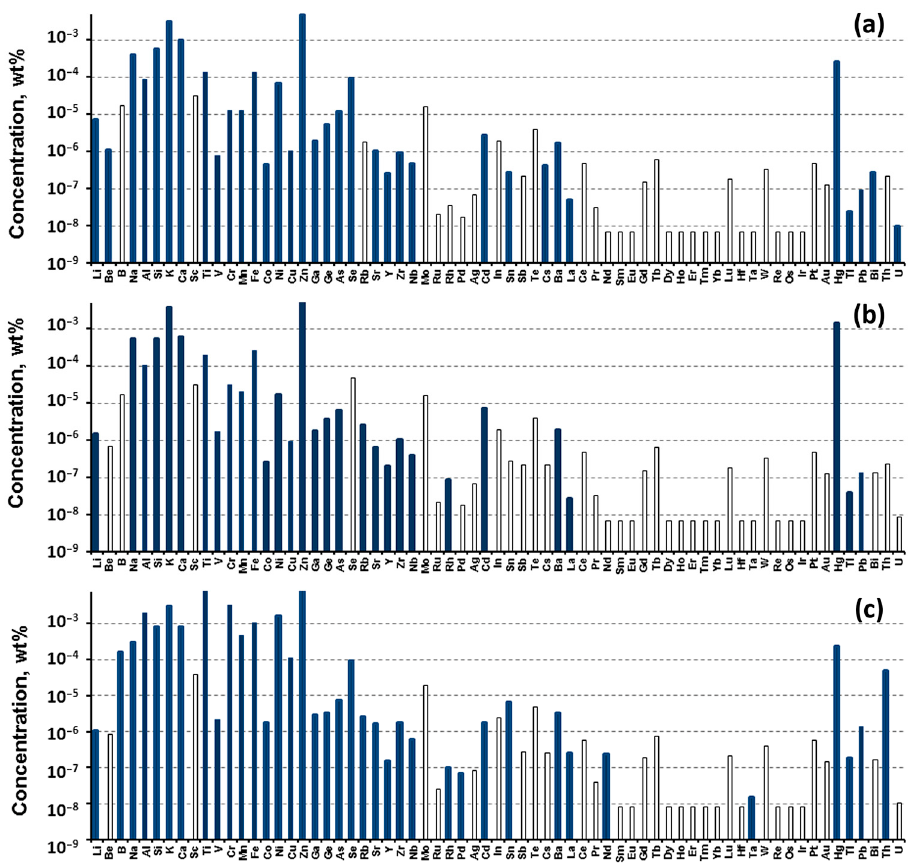
Figure 3. The ICP-MS results of Mg purified by vacuum distillation: ( a ) upper fraction called Mg-S-Top; ( b ) bottom fraction called Mg-S-Bot; ( c ) cube fraction called Mg-S-Cube (Table S1).